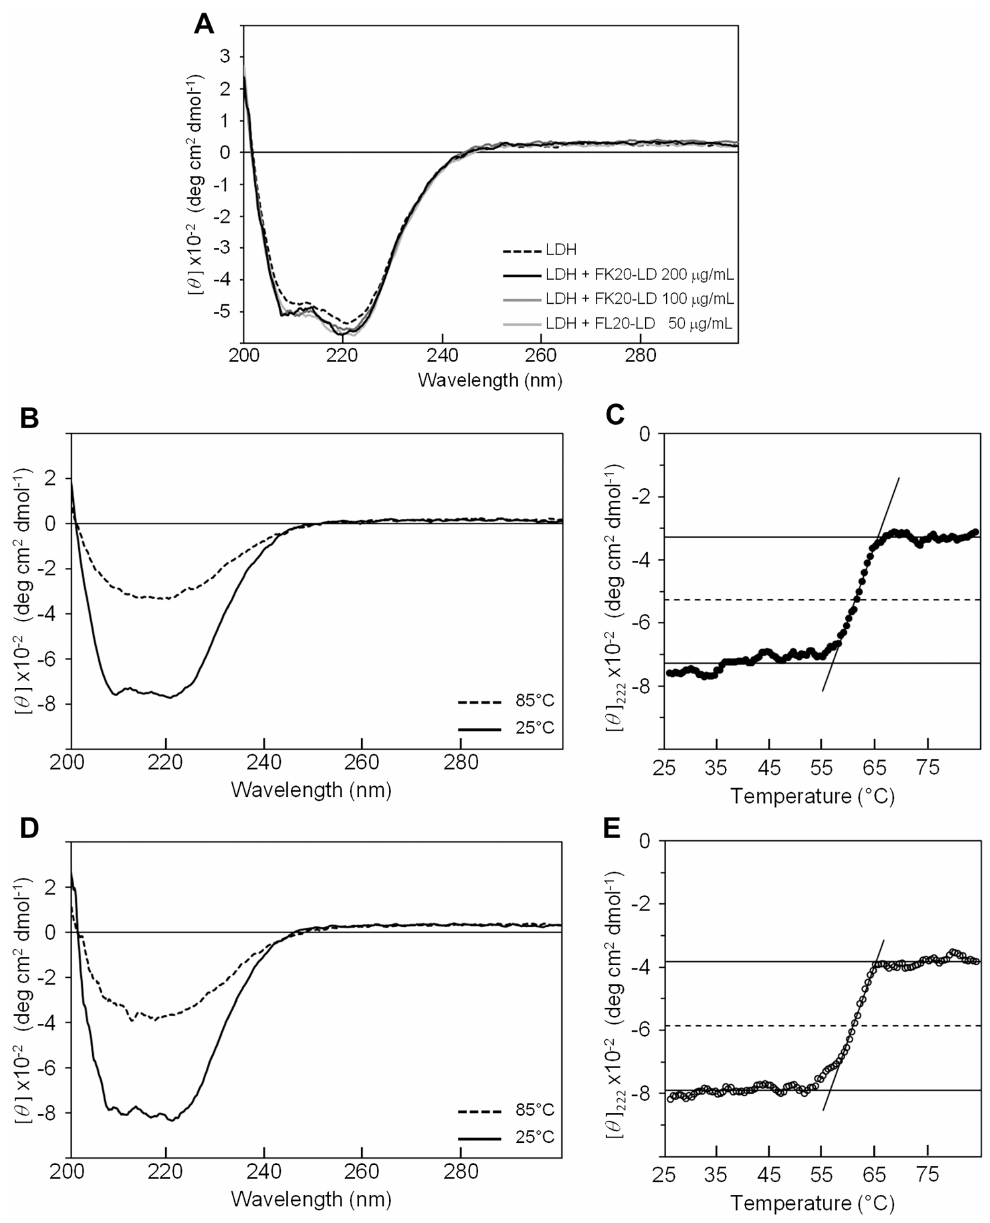
Figure 5 In fl uence of IDP-derived peptide FK20 and its all D-enantiomeric isomer FK20-D to the structure and thermal stability of LDH. (A) CD spectra of 100 m g/ml LDH without (dashed line) or with (solid lines) 50, 100, and 200 m g/ml of FK20-LD at 25 (cid:1) C. (B) CD spectra of 100 m g/ml LDH alone at two temperatures, 25 (cid:1) C and 85 (cid:1) C. (D) CD spectra of 100 m g/mL LDH with 200 m g/ml of FK20-LD at two temperatures, 25 (cid:1) C and 85 (cid:1) C. (C, F) Melting curve of LDH with (E) or without (C) FK20-LD monitored by the residual molar ellipticity (theta) at 222 nm. Full-size DOI: 10.7717/peerj-pchem.20/ fi